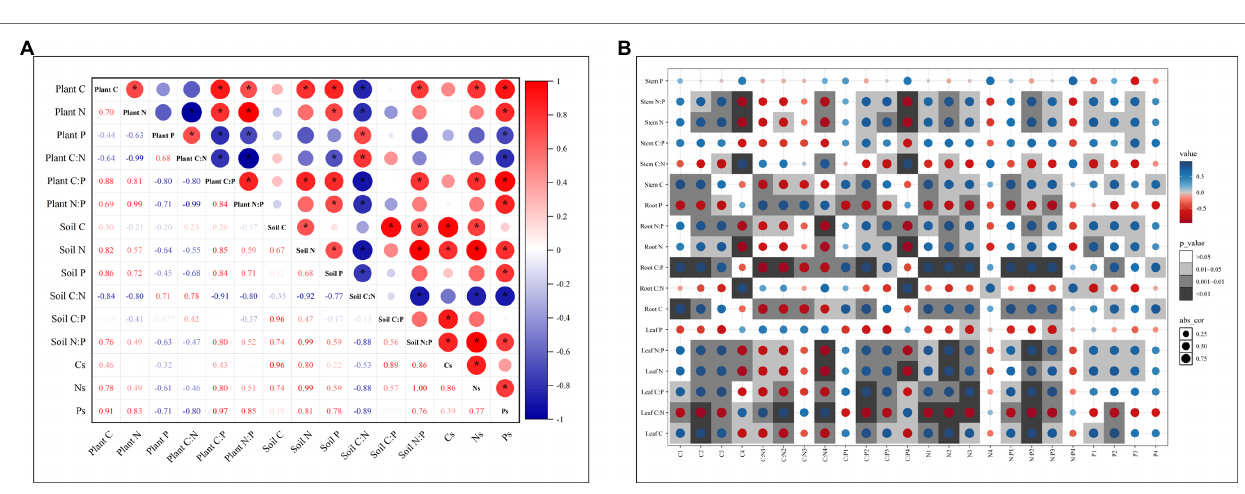
FIGURE 5 | Correlation analysis between C, N, and P contents and ratios of plants and soils (A) , and between C, N, P contents and ratios of plant organs and soil depths (B) . Cs, soil C stock; Ns, soil N stock; and Ps, soil P stock. C1, N1, P1, C:N1, C:P1, and N:P1 are the soil C, N, and P contents and ratios in 0–10 cm depth. C2, N2, P2, C:N2, C:P2, and N:P2 are the soil C, N, and P contents and ratios in 10–30 cm depth. C3, N3, P3, C:N3, C:P3, and N:P3 are the soil C, N, and P contents and ratios in 30–60 cm depth. C4, N4, P4, C:N4, C:P4, and N:P4 are the soil C, N, and P contents and ratios in 60–100 cm